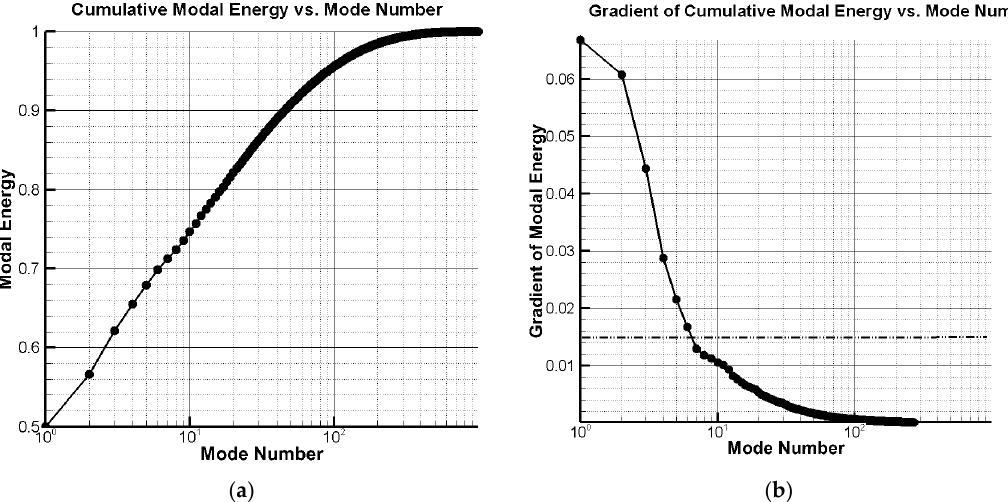
Figure 13. Modal energy and the energy addition ratio for R2 using velocity-based POD. ( a ) Cumulative modal energy. ( b ) Rate of energy addition.